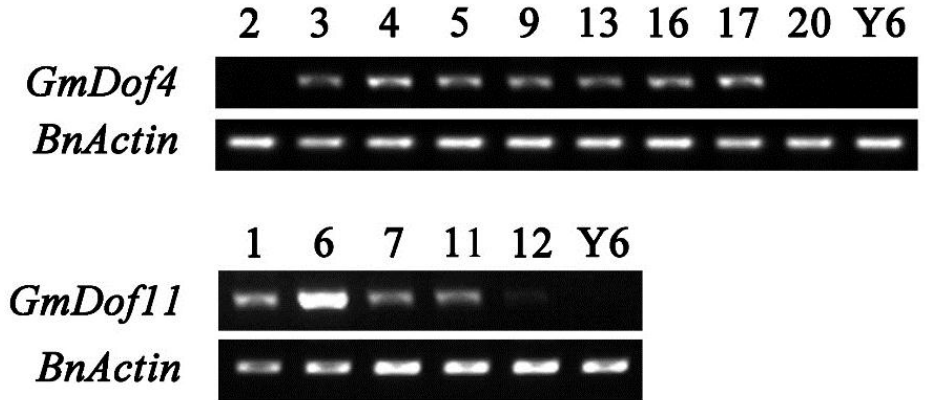
Figure 1. Semi-quantitative RT-PCR analysis of GmDof4 and GmDof11 transgenic plants. BnActin expression is displayed as the internal control. The lengths of the amplification products of BnActin , GmDof4 and GmDof11 were 144 bp, 135 bp and 186 bp respectively.